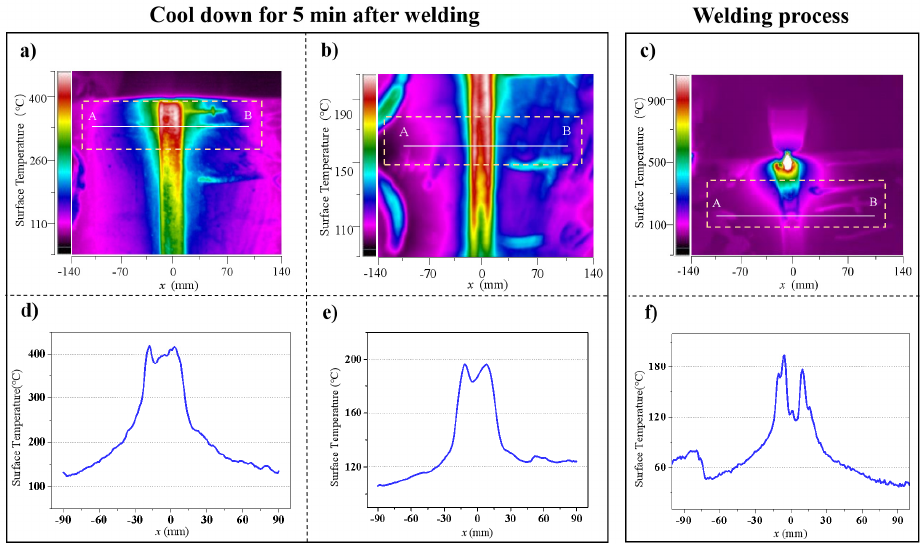
Figure 13. Surface temperature field distribution: ( a – c ) temperature field distribution of the U 0 , U 4 and U 3 welds, respectively; ( d – f ) temperature variation trend along line AB of the U 0 , U 4 and U 3 welds, respectively.